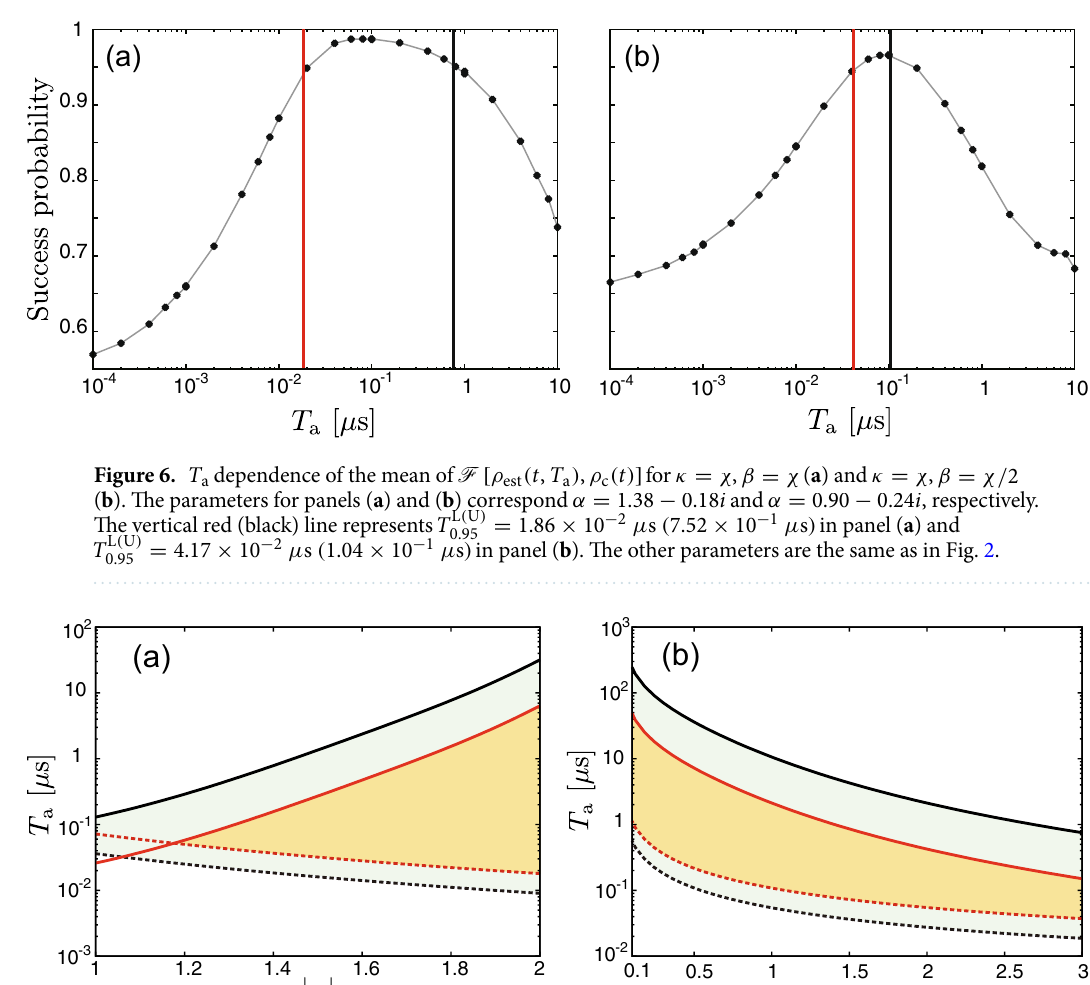
Figure 6. T a dependence of the mean of F ( b ). The parameters for panels ( a ) and ( b ) correspond α The vertical red (black) line represents T L